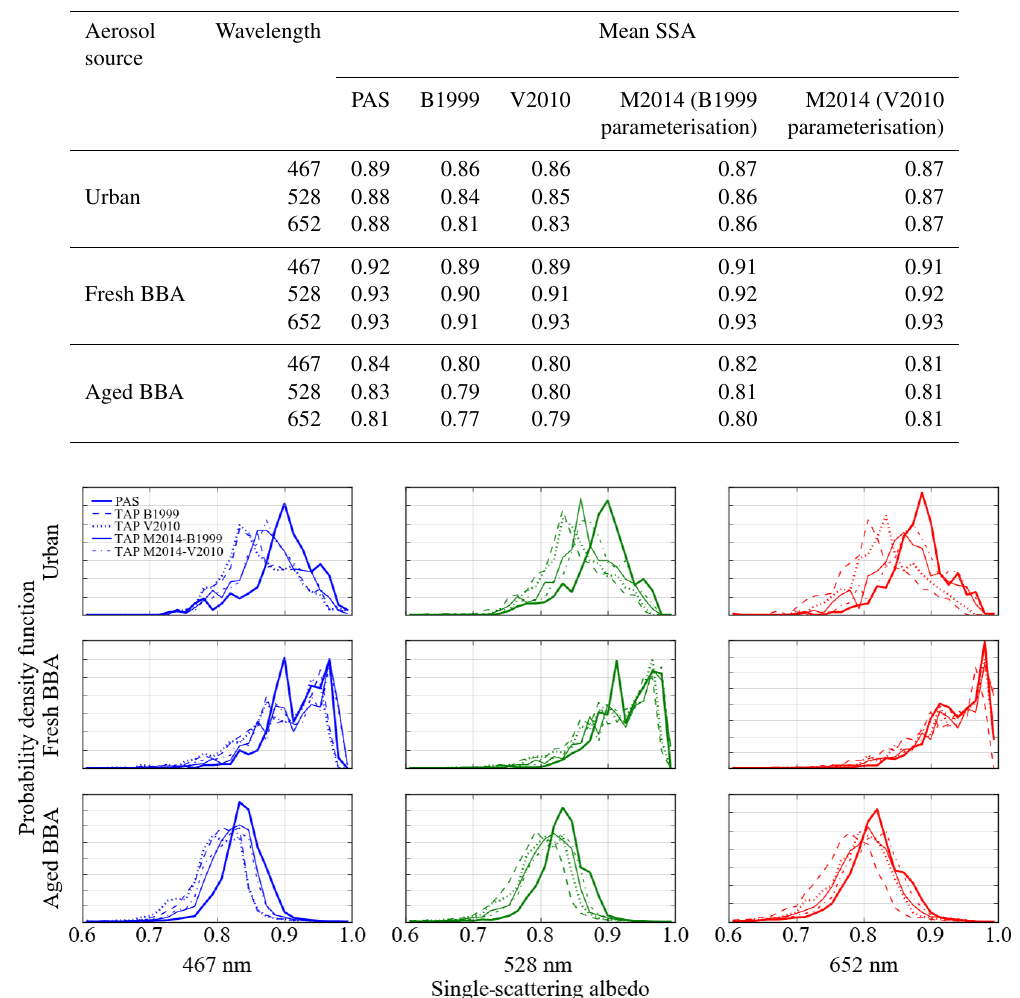
Figure 7. Probability density functions of the single-scattering albedo derived using (i) PAS and CRDS and (ii) TAP and CRDS for the range of TAP correction schemes outlined in Sect. 2.1.1–2.1.3 at wavelengths 467, 528 and 652nm. All absorption coefficients correspond to >1Mm − 1